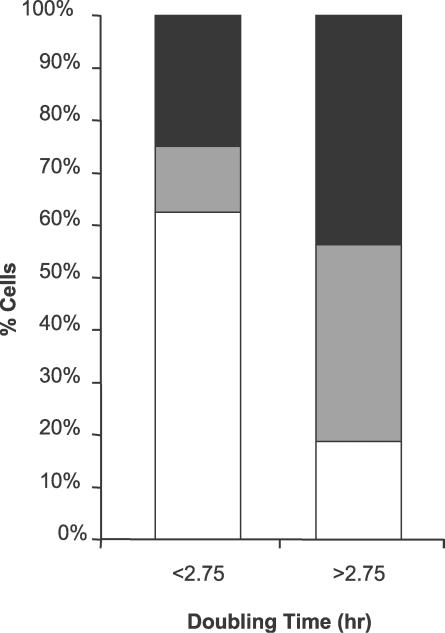
Propagon Numbers Correlate with Single-Cell Doubling TimesWild-type [PSI+] haploids (5V-H19) were analyzed for single-cell doubling time in the presence of GdnHCl and propagon numbers. The percentage of cells containing more than 1,000 (black), between 1,000 and 500 (gray), and fewer than 500 (white) propagons is indicated.